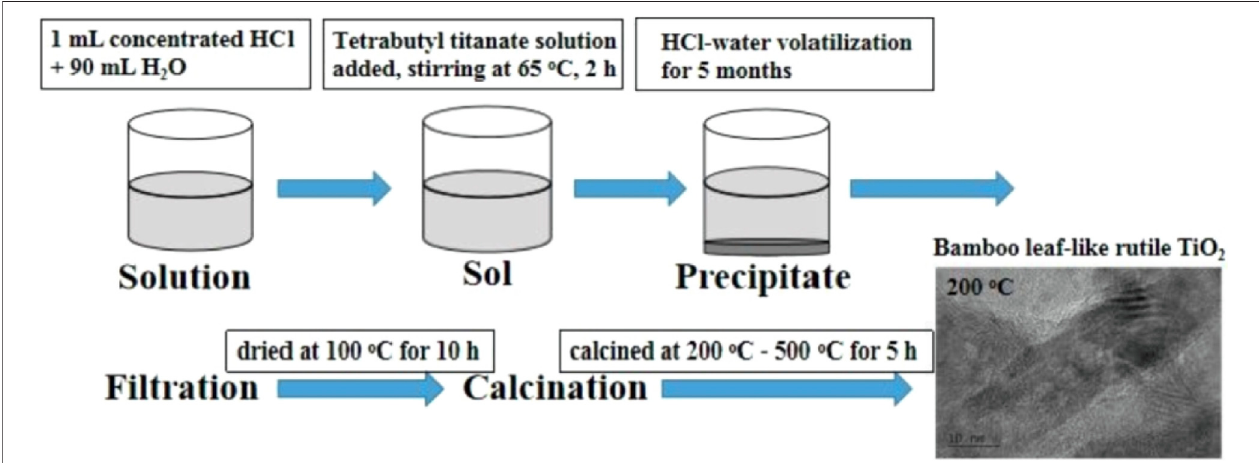
FIGURE 1 | Preparation fl ow chart of pure TiO – water volatilization-assisted precipitation method. Adapted from Ren et al. 2 nanoparticles prepared by the HCl (2022). Copyright © 2021 Elsevier B.V.